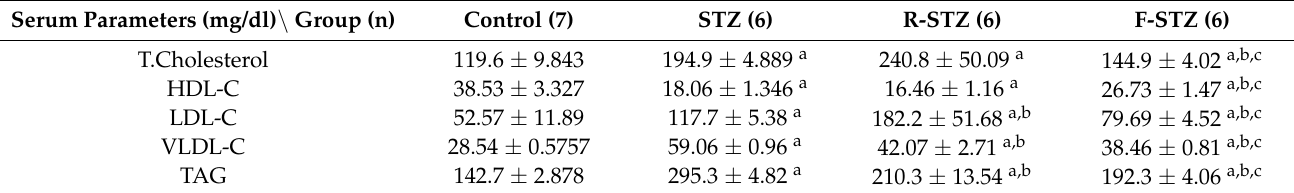
Values are expressed as mean ± SD, a Significant difference from normal control group at p < 0.05, b Significant difference from STZ group at p < 0.05, c Significant difference from R-STZ group at p <